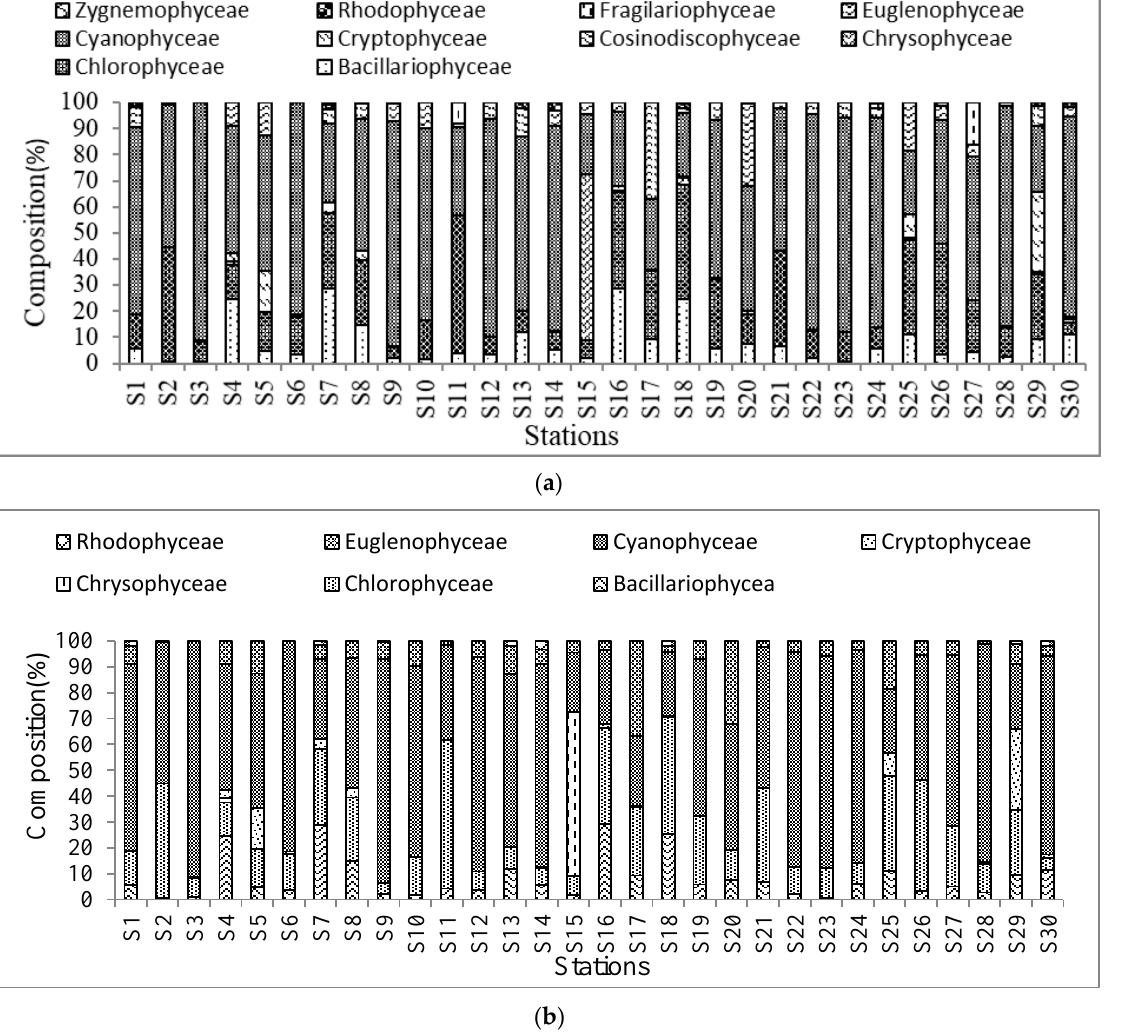
Figure 2. Composition (%) of ( a ) algal classes at different stations/ponds, ( b ) harmful algal classes at different stations/ponds.